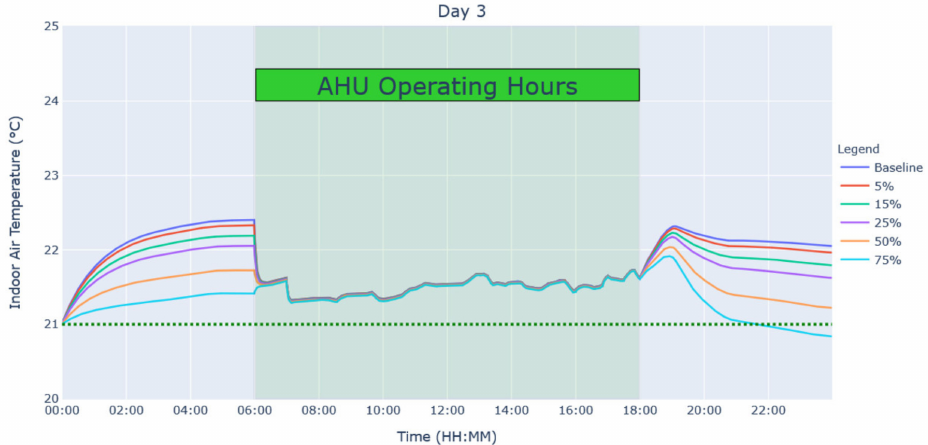
Figure 6. Daily internal air temperature profile for model sensitivity analysis of Day 3 data, with AHU operating hours highlighted by green shaded area.